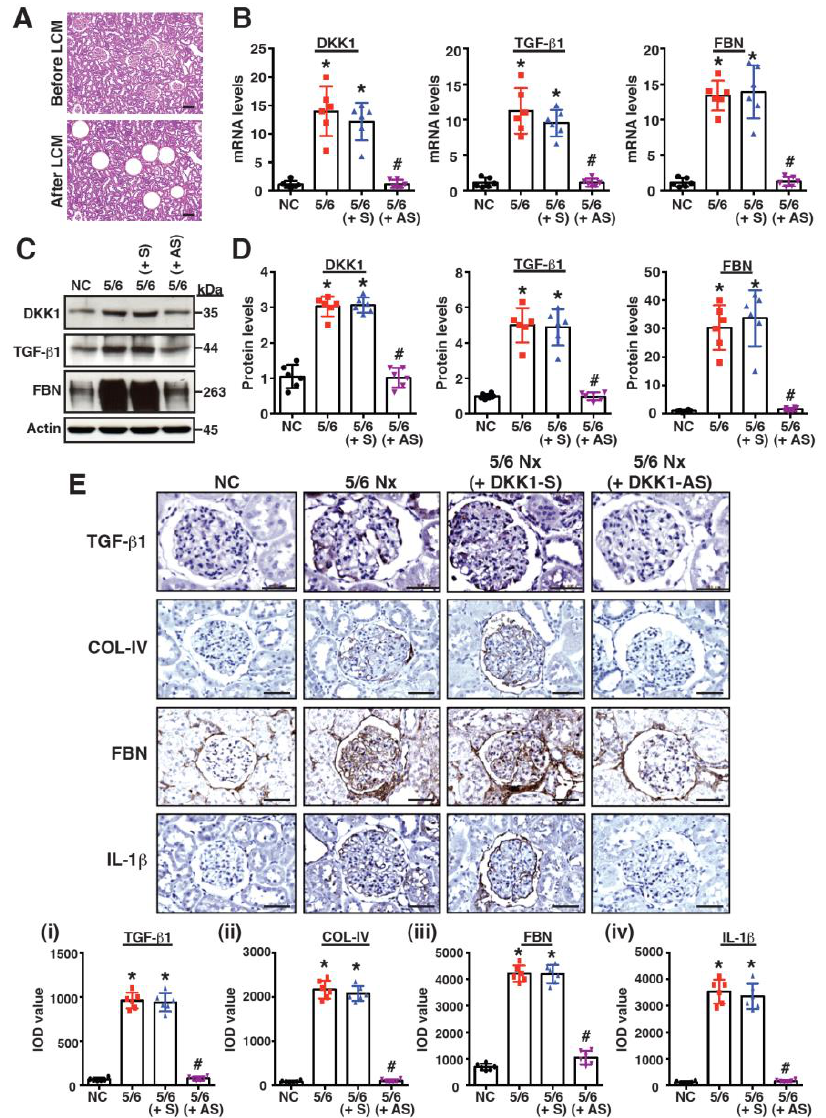
Figure 3. Evaluation of the expression levels of profibrotic and proinflammatory factors in renal tissues of the sham-operated rats and the 5/6 Nx rats left untreated or treated with DKK1-S or DKK-AS. ( A ) Representative photographs of renal sections before and after capturing glomerular compartments using laser capture microdissection (LCM). Scale bars: 100 µ m. ( B ) Quantitative RT-PCR analysis of DKK1, TGF- β 1 and fibronectin (FBN) mRNAs in isolated glomeruli microdissected from kidney sections of different groups. Quantitative data are represented as mean ± SD (n = 6 for each group). * p < 0.05 versus the sham group, # p < 0.05 versus the untreated 5/6 Nx group. ( C ) Representative images of Western blot analysis for the expression of DKK1, β -catenin, TGF- β 1 and FBN in renal tissues of different groups. ( D ) Quantitative analysis of Western blots for DKK1, β -catenin, TGF- β 1 and FBN in renal tissues of different groups. Data are plotted as mean ± SD (n =